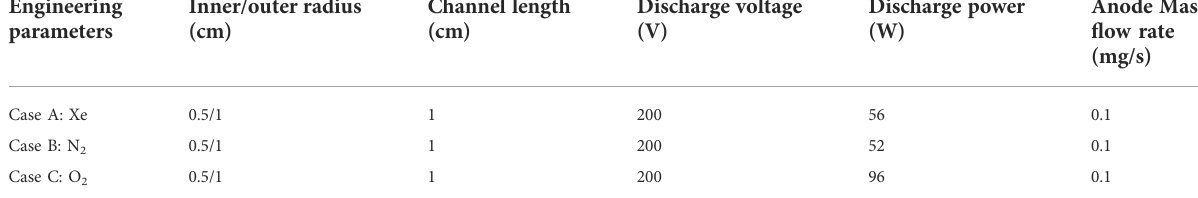
TABLE 5 Engineering parameters used for the SPT20 simulations.